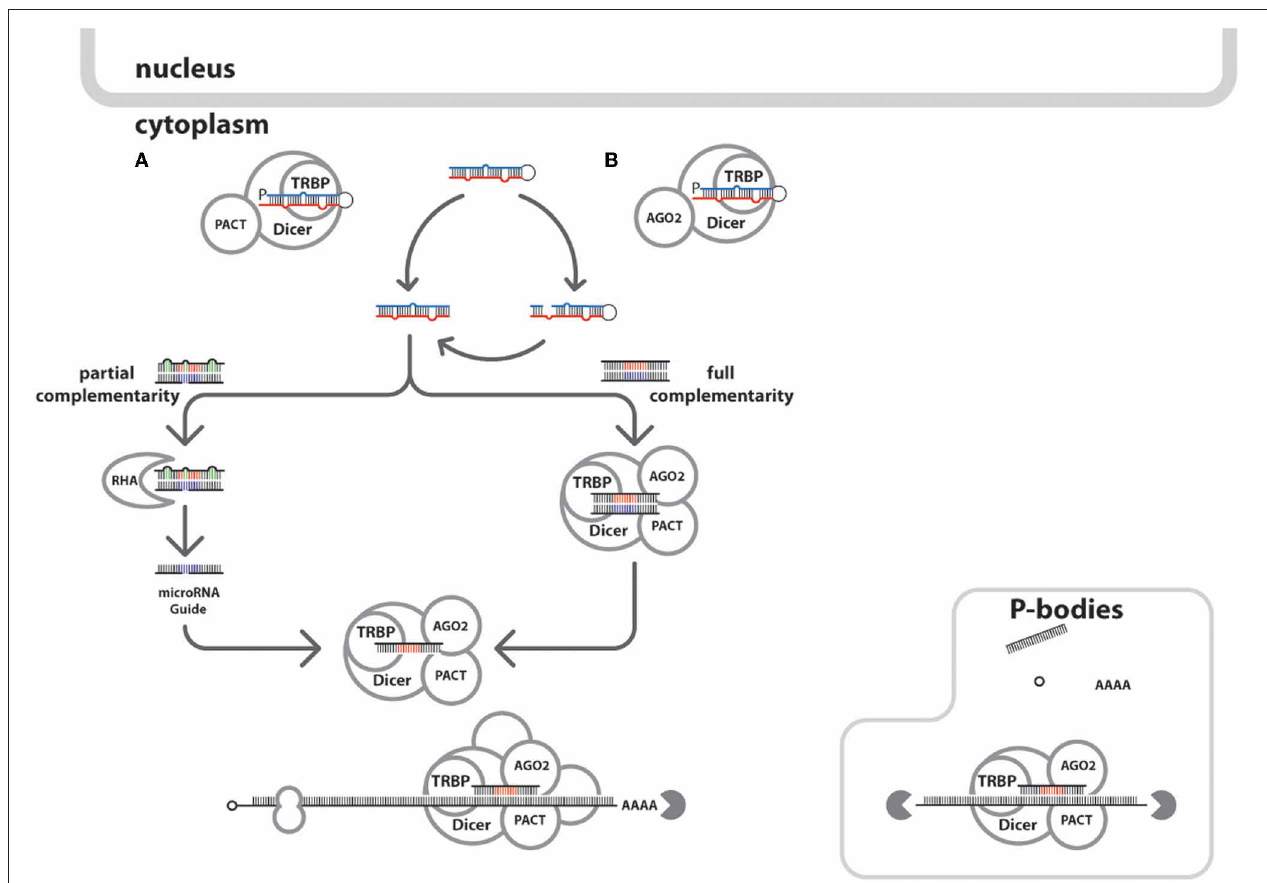
FIGURE 3 | Cytoplasmic events of the integrated cellular and HIV-1 microRNA biogenic pathways. Mature microRNAs are processed in the host cytoplasm after the pre-microRNAs are shuttled from the nucleus. There are two ways the processing can happen: (A) by the Dicer/TRBPorTARBP or TARBP/PACT leading to the generation of microRNA duplexes, or (B) via the Ago proteins-assisted generation of pre-cursor microRNA which in the end generate the microRNA duplexes via Dicer action. The circular arrows show the formation microRNA duplex produced after the circuitous cleavage reactions of either Dicer, Ago2 proteins. Also shown in the microRNAs duplexes are the representative seed sites in red and blue and green indicates mismatches and bulges. Depending on the degree of complementation of the guide strands in the microRNA:RISC assembly to its